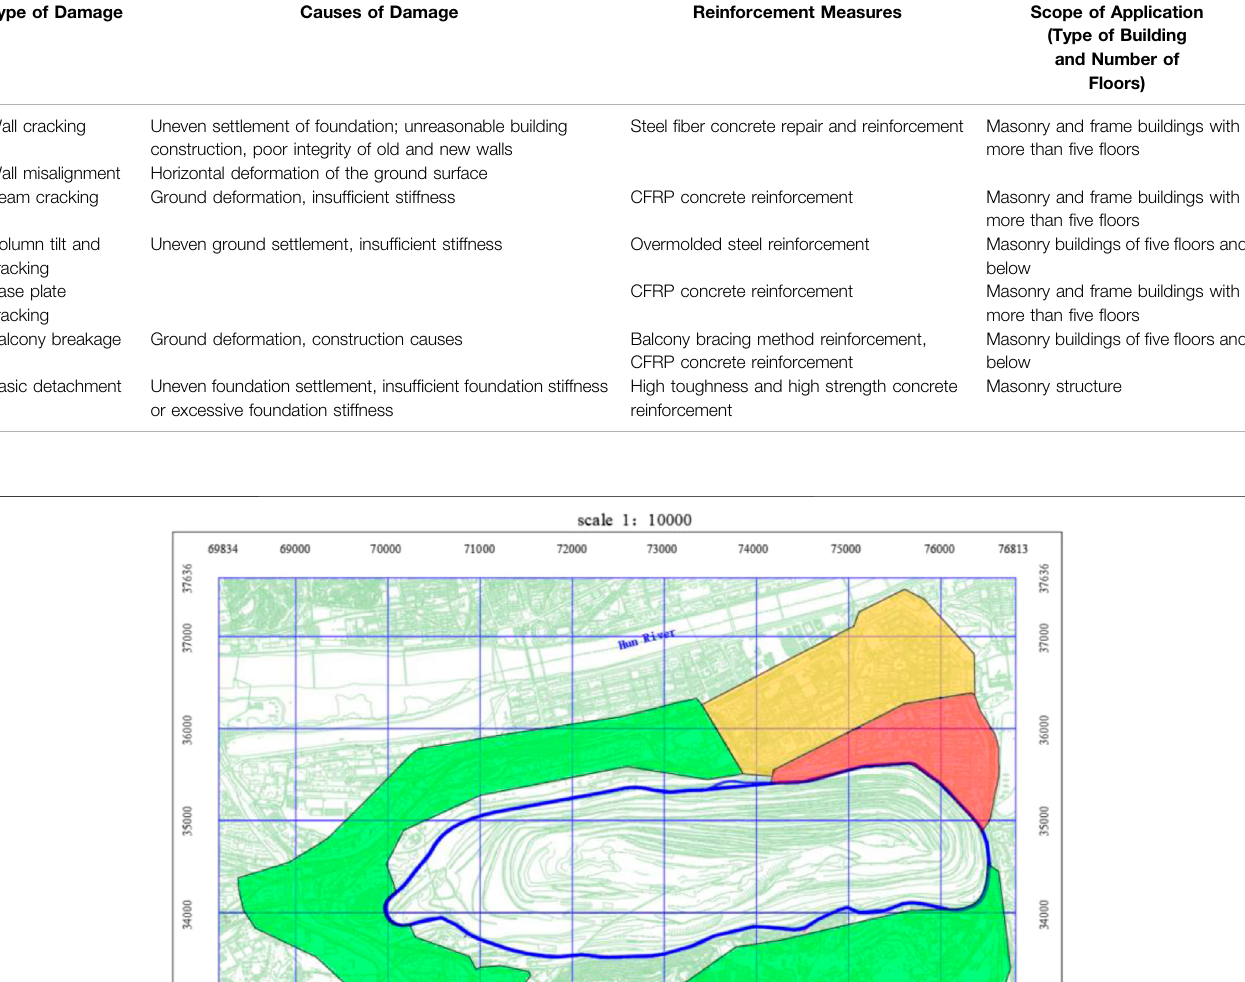
Frontiers in Earth Science |